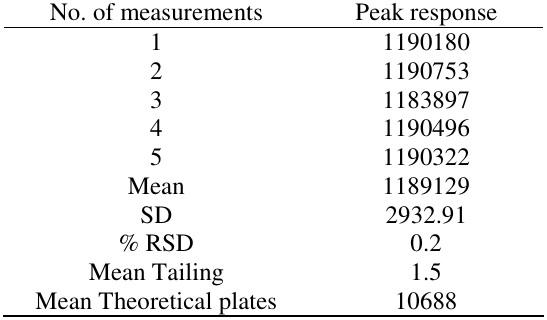
Table 3. Data of system suitability / Instrument precision